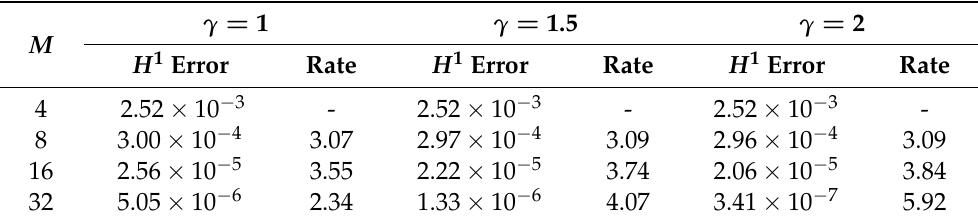
Table 4. The H 1 -norm errors in space for the non-smooth case in Example 1 with τ = 1/1000 and α =